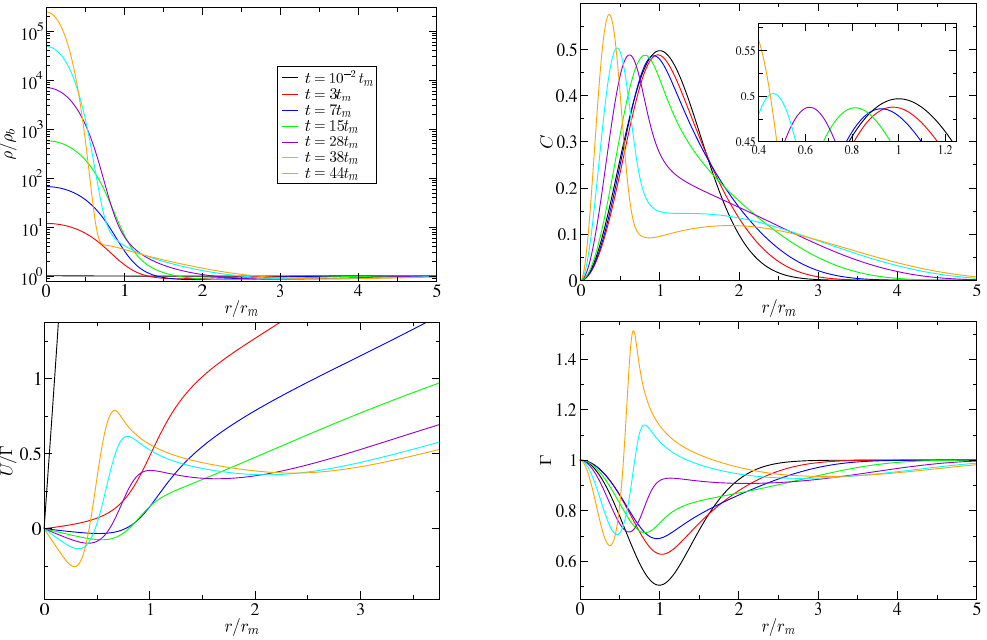
Figure 9. Dynamics of different magnitudes in the case of a perturbation close to the critical threshold δ m ≈ δ c (Gaussian profile) at given times t . In particular, δ m = 0.49775 and δ c = 0.49774 ± 2 × 10 − 5